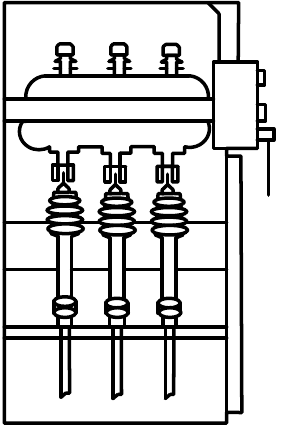
Figure 1. Internal environment of the switchgear.